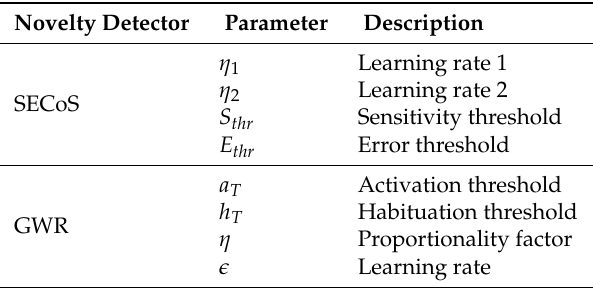
Figure 4. Flowchart of the visual novelty detection for specific tasks. In the training phase, the novelty filter learns to detect a specific object. In the inspection phase, the evolved model is used to detect the object(s) in the environment. Table 1. Parameters to be tuned for each novelty